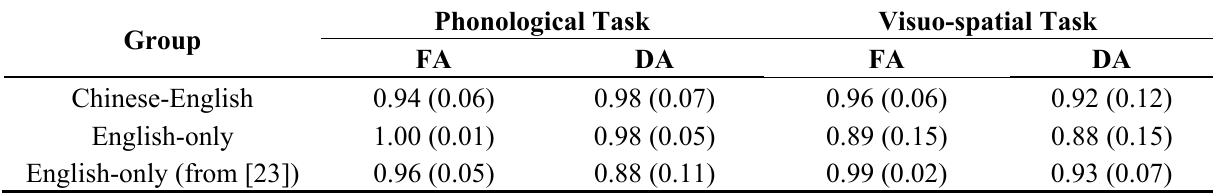
Table 2. Mean Distracting Task Performance in Chinese-English and English-only Groups, and in an English-only group (from Fernandes and Guild 2009 [23]) under Full (FA) and Divided Attention (DA) Conditions for Each Task (Standard Deviations in